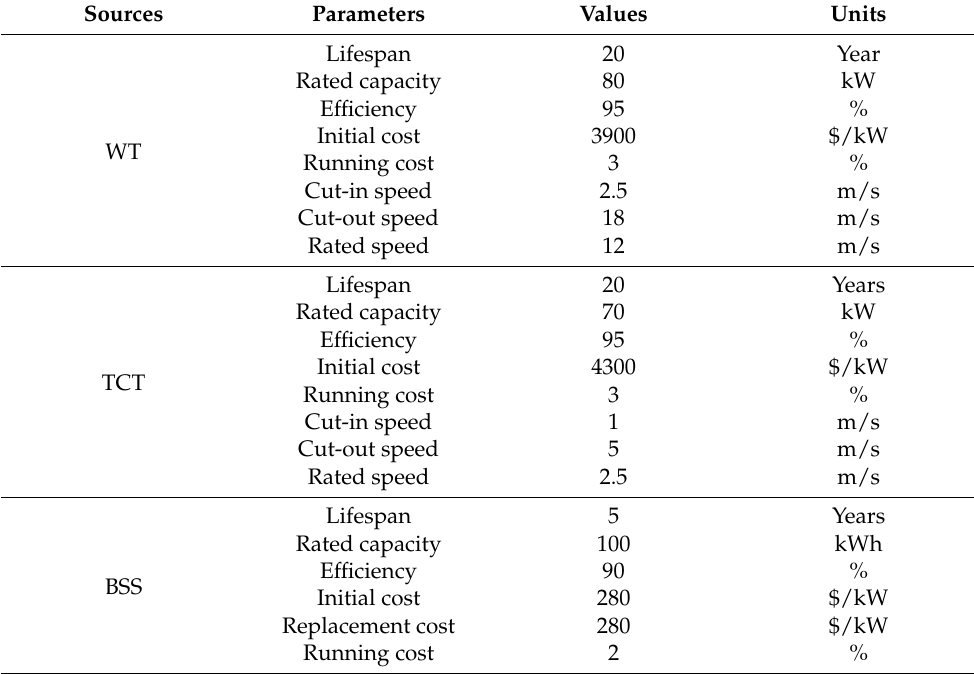
Table 2. Parameters of the major components.